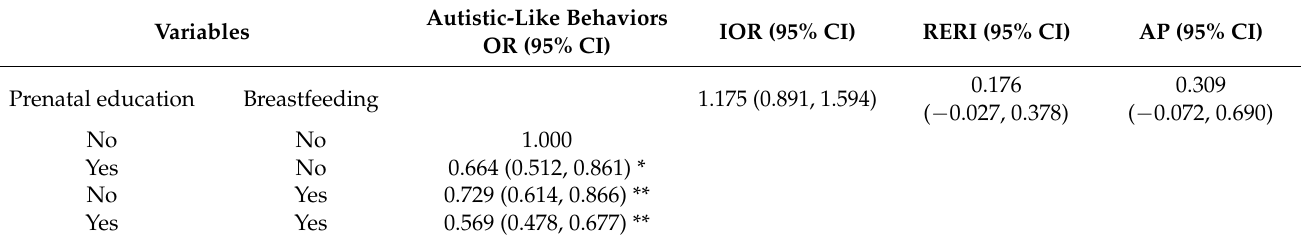
Table 6. The combination effect of maternal participation in prenatal education and breastfeeding on autistic-like behaviors in pre-schoolers #